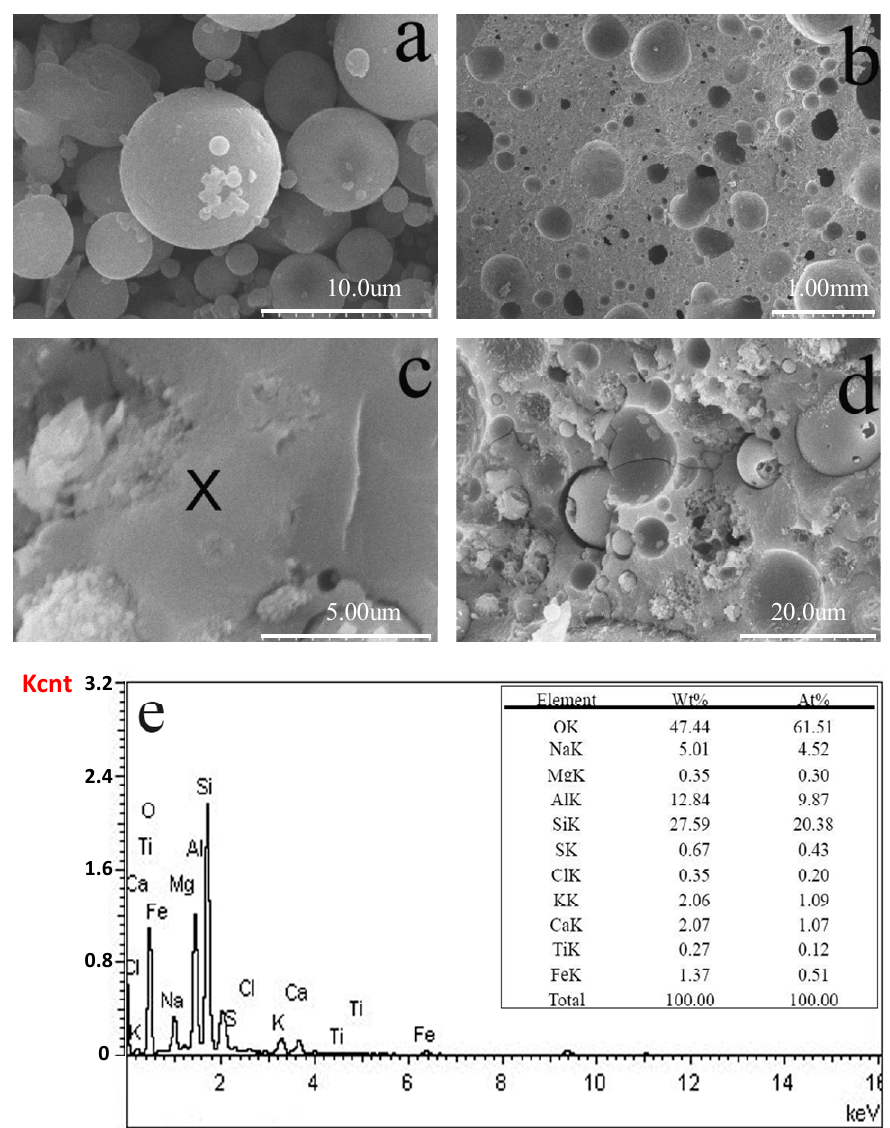
Figure 9. SEM–EDS (Energy Dispersive Spectrometer) characterization of fly ash and GLWC after curing for 28 days. ( a ) SEM microphotography of raw fly ash; ( b , c , d ) SEM microphotography of GLWC; ( e ) chemical characterization by EDS of the sample area marked as X on the photograph.